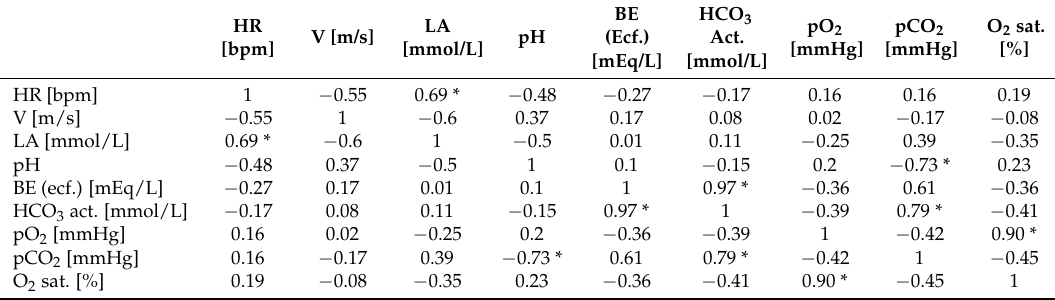
Table 1. Correlations between acid-base balance parameters of the runners during a run over a distance of 100